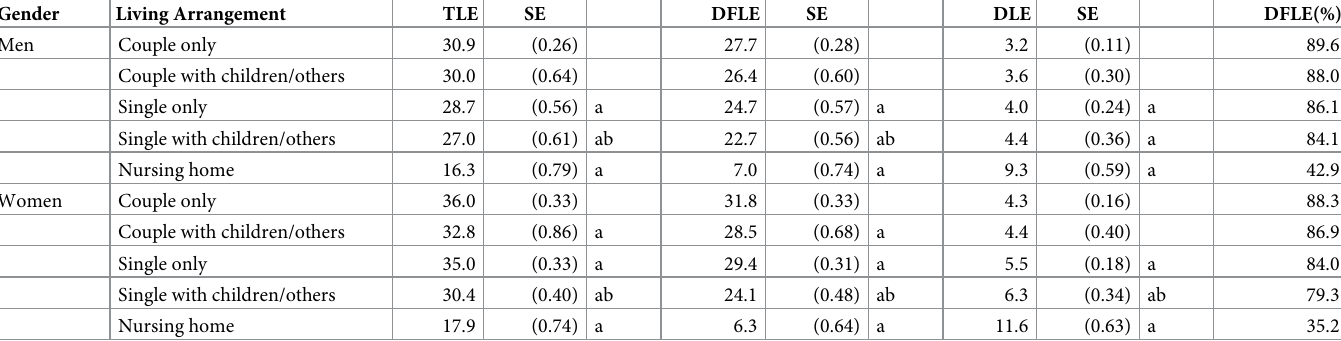
Table 5. Total, disability-free, and disabled life expectancy by gender and living arrangement for non-Hispanic whites at age 50: Population-based estimates: Sta- tus-based estimates with initial health state being disability-free.